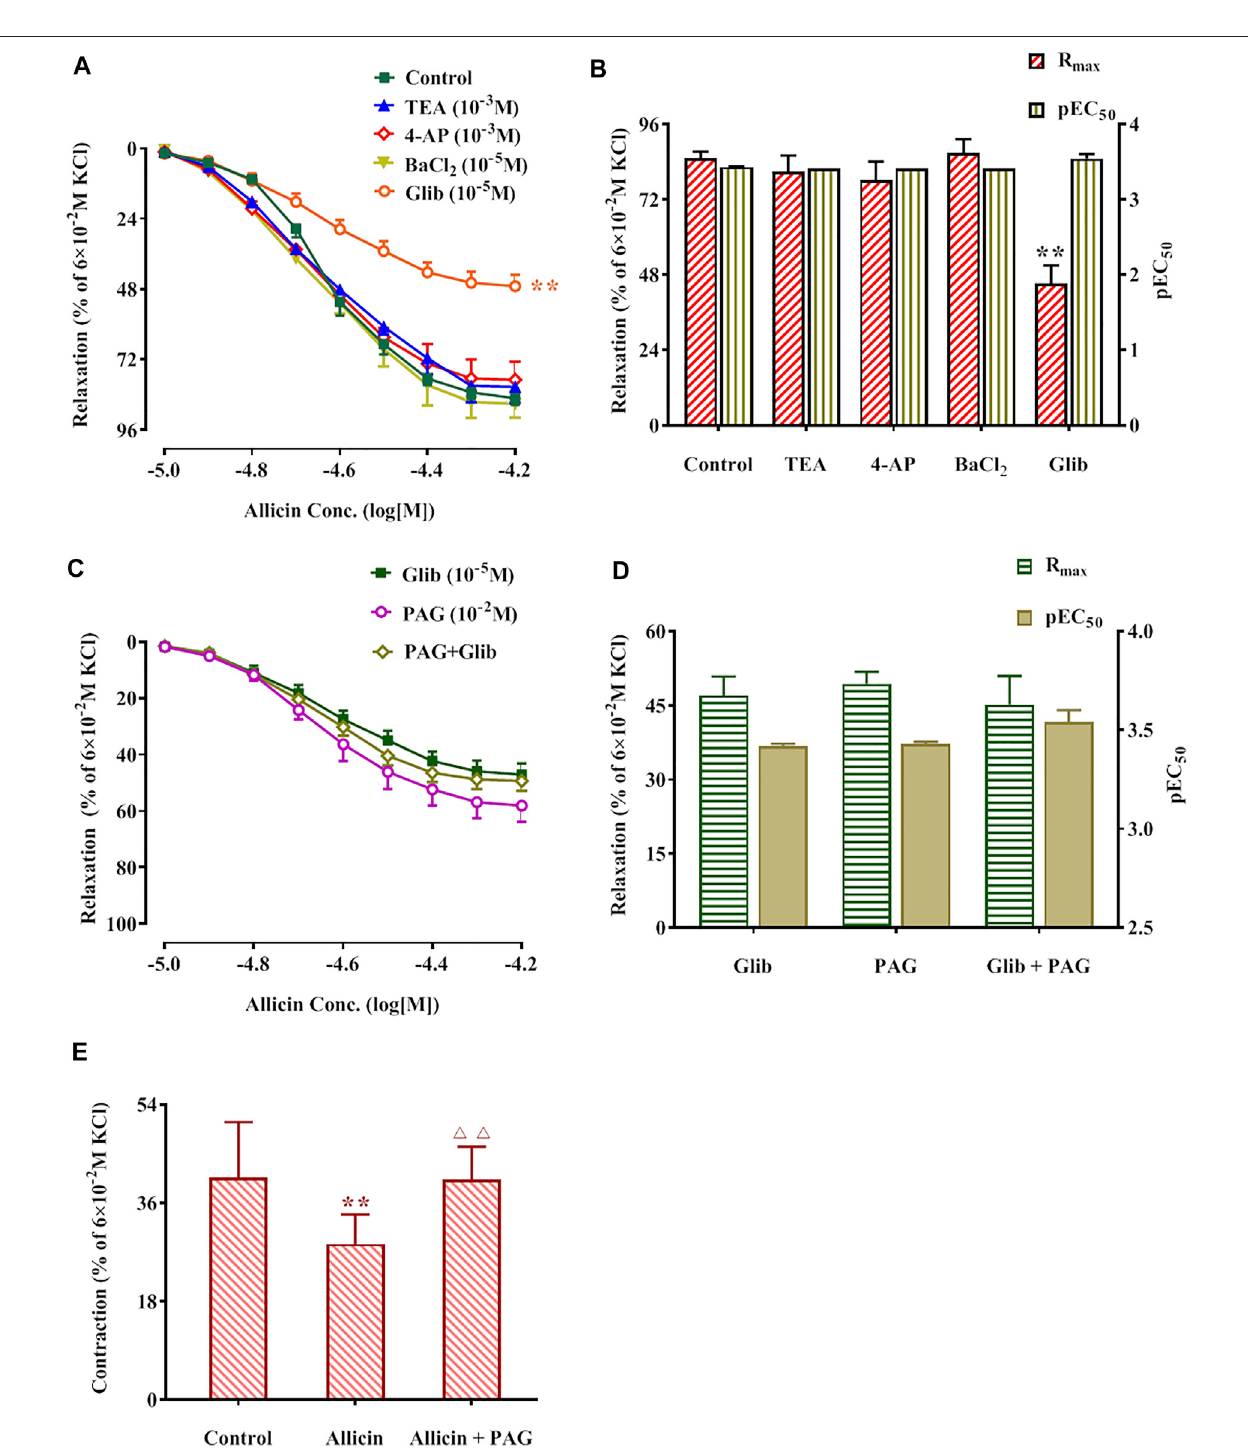
FIGURE 6 | Potassium pathway inhibitors reduced allicin-induced diastolic effects in rat coronary arteries via H 2 S and allicin inhibited caffeine-induced coronary artery contraction. (A,B) The diastolic effect curves of allicin and R max and pEC 50 after adding saline and four potassium pathway inhibitors respectively; (C,D) The diastoliceffectcurvesofallicinandR max andpEC 50 afteraddingPAGor/andGlib,respectively; (E) Effectofallicinoncaffeine-inducedcontraction.Dataarepresentedas mean ± S.E.M (8 rings in each group from 4 ‒ 8 rats). ** p < 0.01 vs. control; △△ p < 0.01 vs. the Allicin group. Abbreviations: PAG, DL-propargylglycine; Glib, glibenclamide; 4-AP, 4-aminopyridine; TEA, tetraethylamine; pEC 50 , half-maximal effect; R max, maximum relaxation.